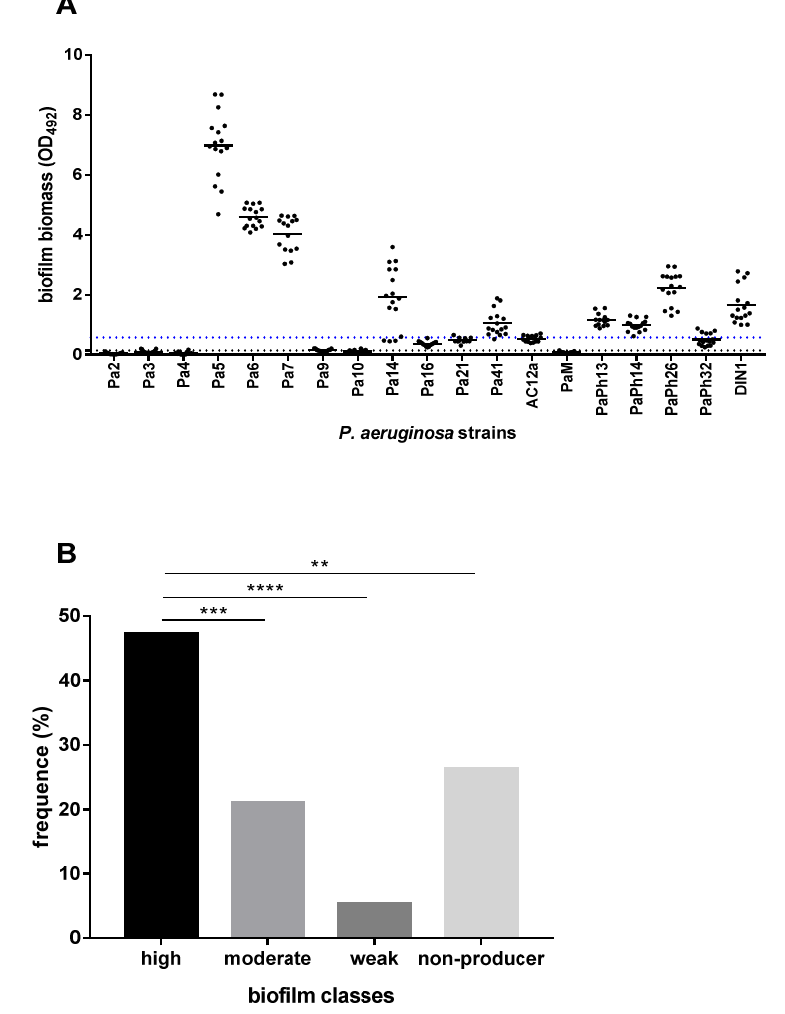
Figure 1. Biofilm formation by 19 P. aeruginosa strains from CF patients. The amount of biofilm formed on polystyrene following 24 h of incubation at 37 ◦ C was measured by the microtiter plate crystal violet method. Each strain was tested, in quadruplicate, on four different occasions ( n = 16). ( A ) Results were subtracted by negative control (OD 492 = 0.092) and shown as a scatter plot, with the horizontal solid line indicating the mean OD value. The horizontal dotted black line shows the cut-off value for biofilm formation (ODc = mean + 3 x standard deviation of negative control wells; ODc = 0.143), whereas the blue one indicates the cut-off value for high biofilm-former class (OD 492 > 0.572). ( B ) According to Stepanovi´c et al. [21], each strain was assigned to one of the following groups: non-biofilm-former (OD 492 < 0.143), weak biofilm-former (0.143 < OD 492 ≤ 0.286), moderate biofilm-former (0.286 < OD 492 ≤ 0.572), and high biofilm-former (OD 492 > 0.572). Results are shown as the percentage of distribution of each group. Statistical significance at Fisher’s exact test: ** p < 0.01, *** p < 0.001, **** p < 0.0001.